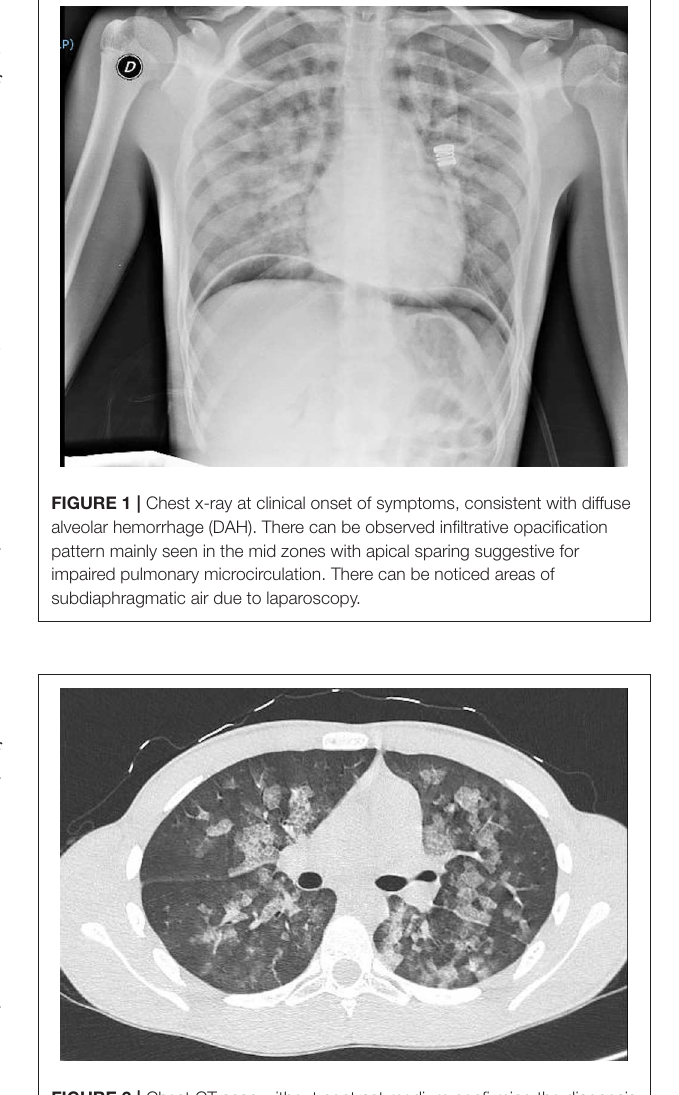
FIGURE 2 | Chest CT scan without contrast medium confirming the diagnosis of